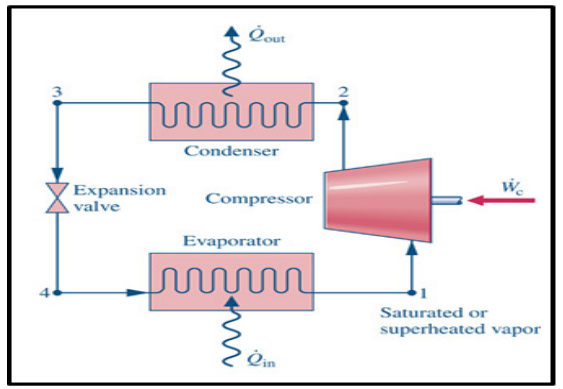
Fig. 1A. Schematic of the vapor compression refrigeration cycle.